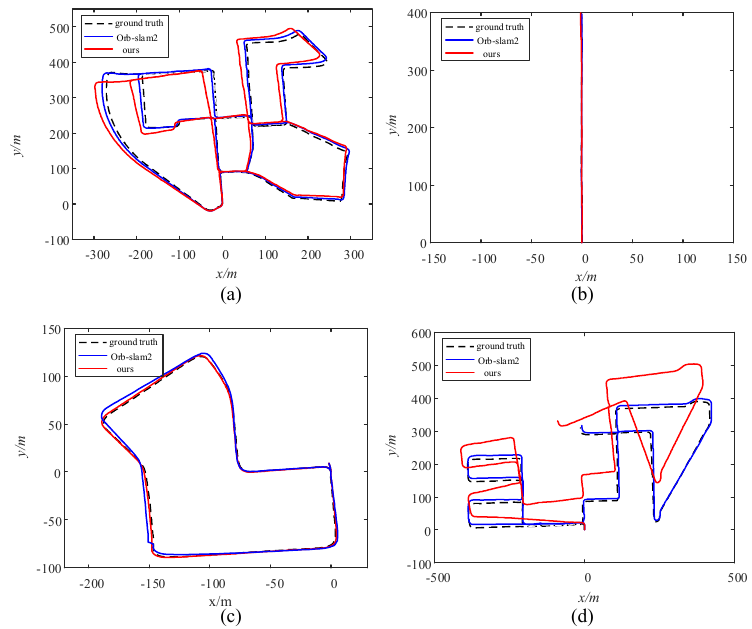
Figure 15. Performance of different algorithms on typical trajectories from the KITTI dataset. ( a ) is the 00 sequence with multiple loops, ( b ) is the 04 sequence with a short straight line, ( c ) is the 07 sequence with one loop, and ( d ) is the 08 sequence with a long line and no loops.